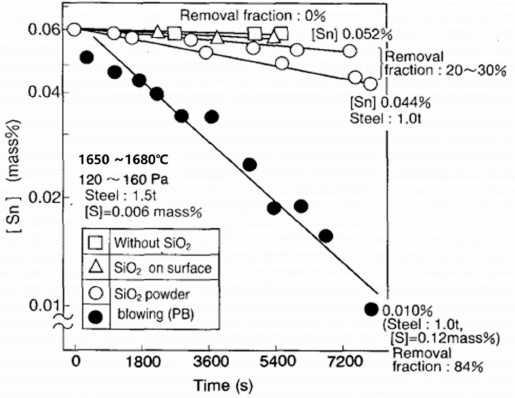
Figure 3. Variation of Sn content in molten iron with time under low pressure